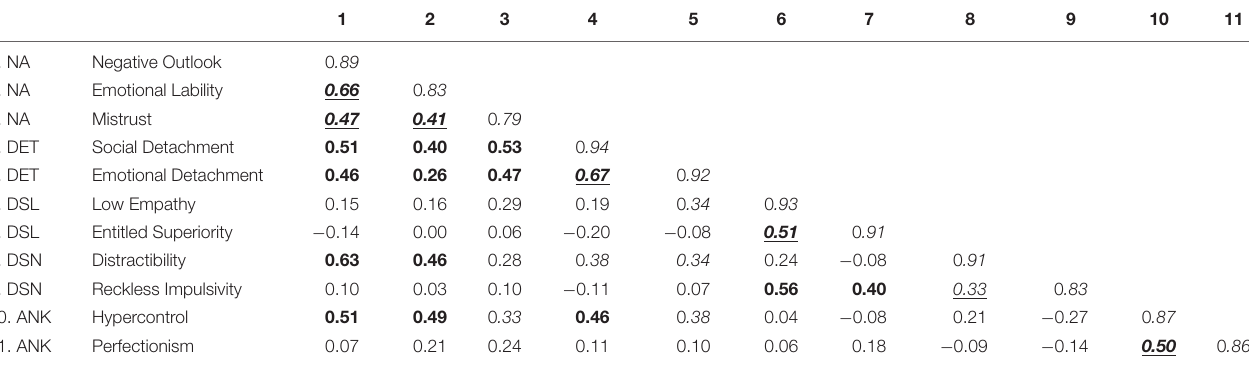
N = 383 community adults. ICD-11, International Classification of Diseases, 11 th Ed. (World Health Organization, 2020). NA, Negative Affectivity; DET, Detachment; DSL, Dissociality; DSN, Disinhibition; ANK, Anankastia. McDonald’s omegas are in the diagonal. Correlations > 0.40 are bolded ; those < 0.40 and > 0.30 are